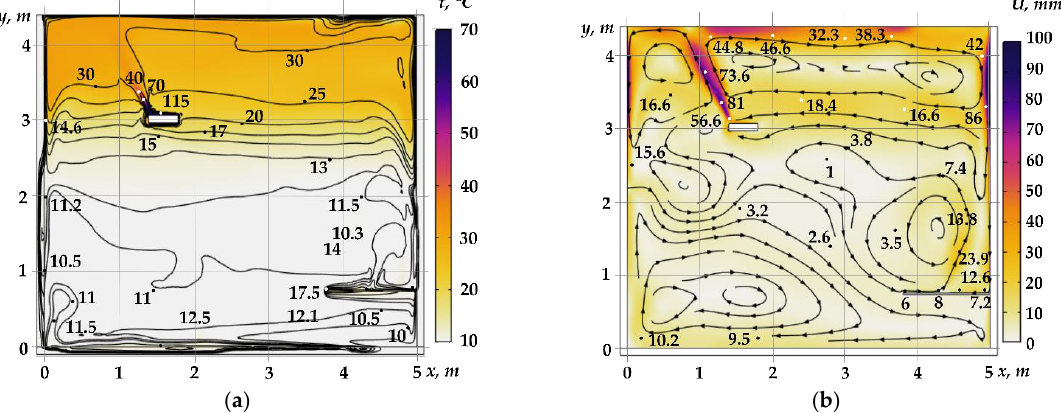
Figure 15. Temperature fields ( a ) and streamlines ( b ) for the area with a panel near the right wall ( X Tb = 4.4 m, Y Tb = 0.755 m) at τ = 60 min. If the panel is located with coordinates X Tb = 2.5 m, Y Tb = 0.755 m, the rising flow of heated air from the panel is formed almost in the center of this panel (Figure 14a).